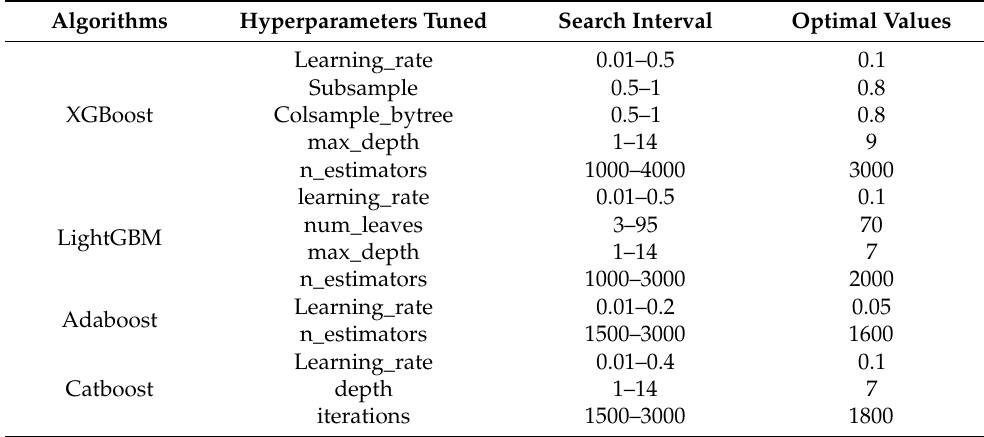
Figure 5. Superlearner flowchart. Table 2. Lists the boosting algorithms applied in our work, the tuned hyperparameter search interval, and the optimal hyperparameter values. For typical hyperparameters, we have used a common search interval that can lead to meaningful insights by